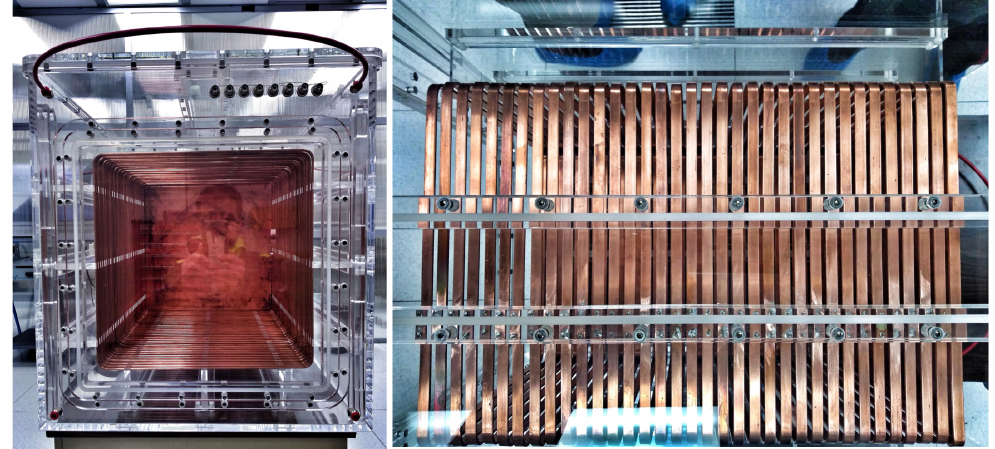
Figure 9. Pictures of the LIME detector. Left : front view of the field cage with the copper cathode visible at the end. Right : field cage copper rings in the gas